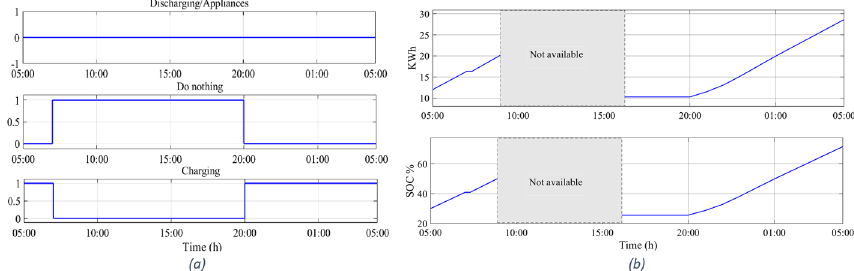
Fig. 18 a PEV management fuzzy controller output, b PEV power and SOC %